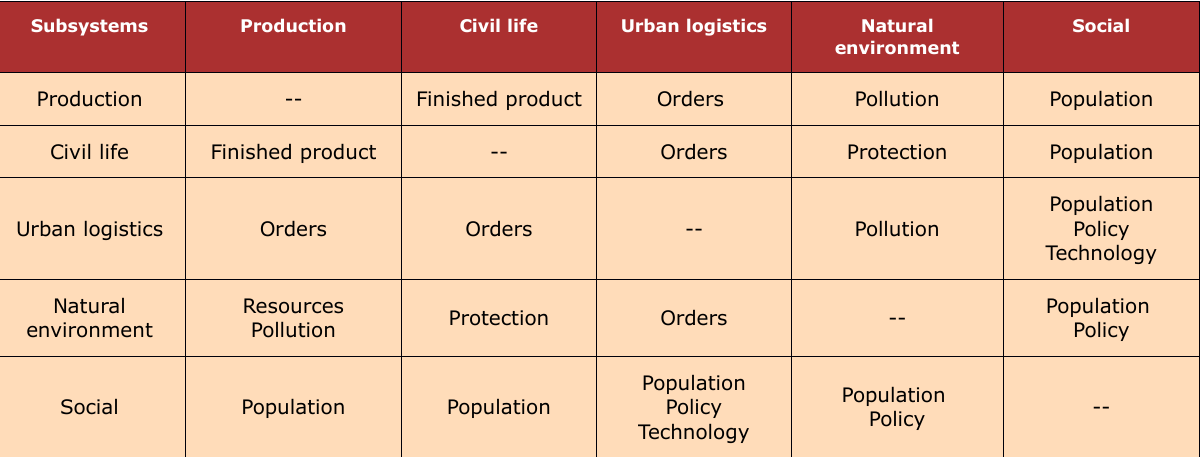
Table 1. Key indexes between